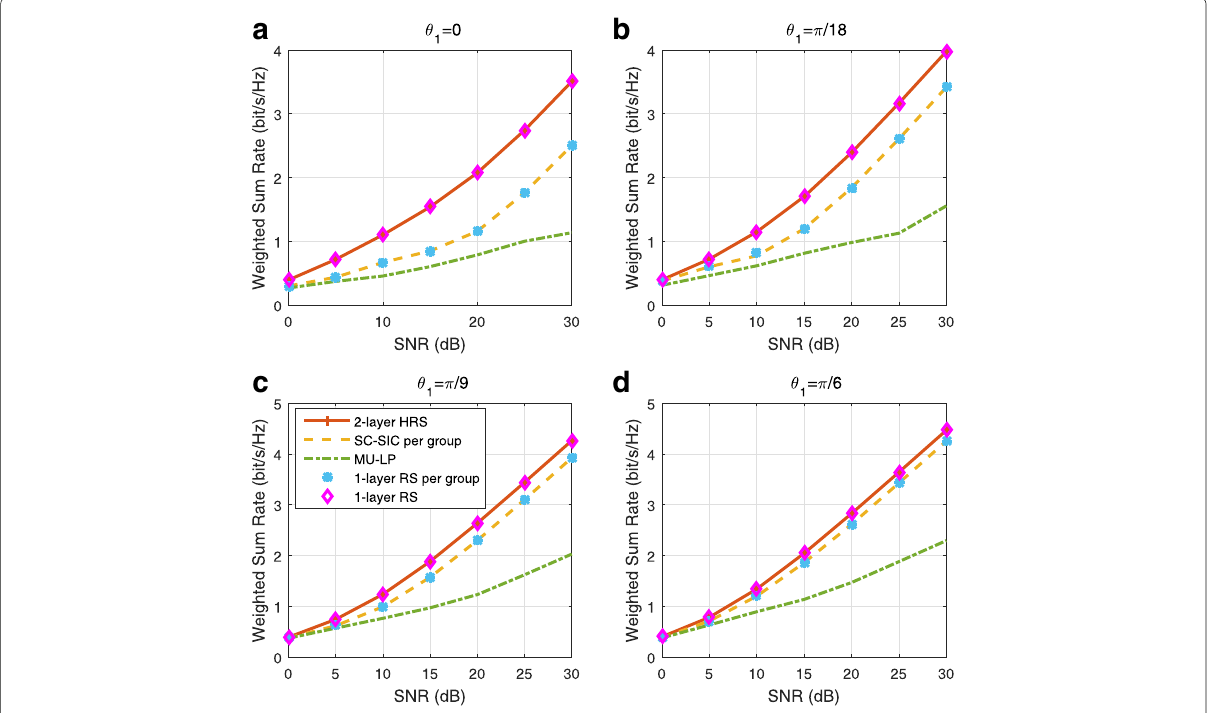
Fig.58 Weightedsum rate versus SNR comparison of different strategies for overloaded four-user deployment with perfect CSIT, γ 1 = 1, θ 2 = θ 1 + π